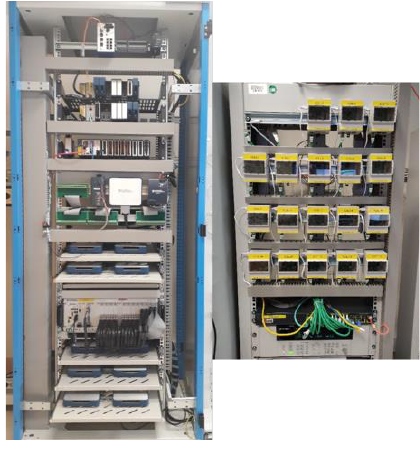
Fig. 13. DAQ experimental devices for CAREDAS